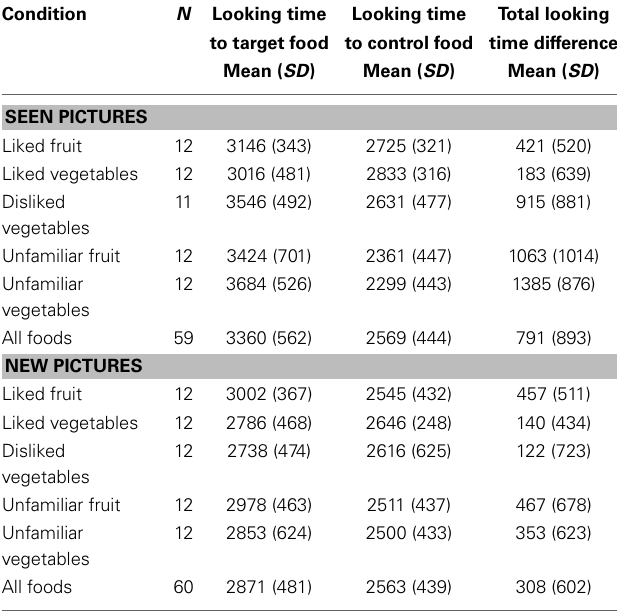
Table 1 | Mean looking times toward target and control foods and mean total looking time differences (target—control) for the children in each condition of Experiment